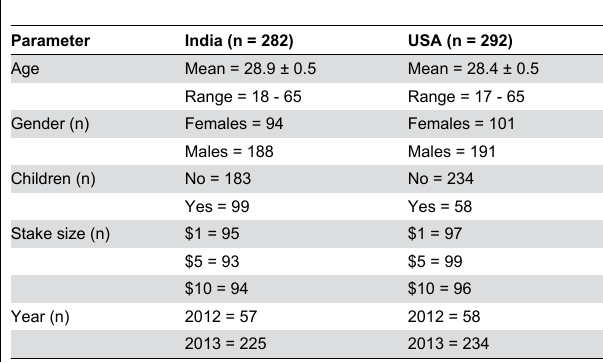
Table 1. Information on mean values ± SE (where appropriate) and sample sizes for the explanatory terms used in the statistical models.